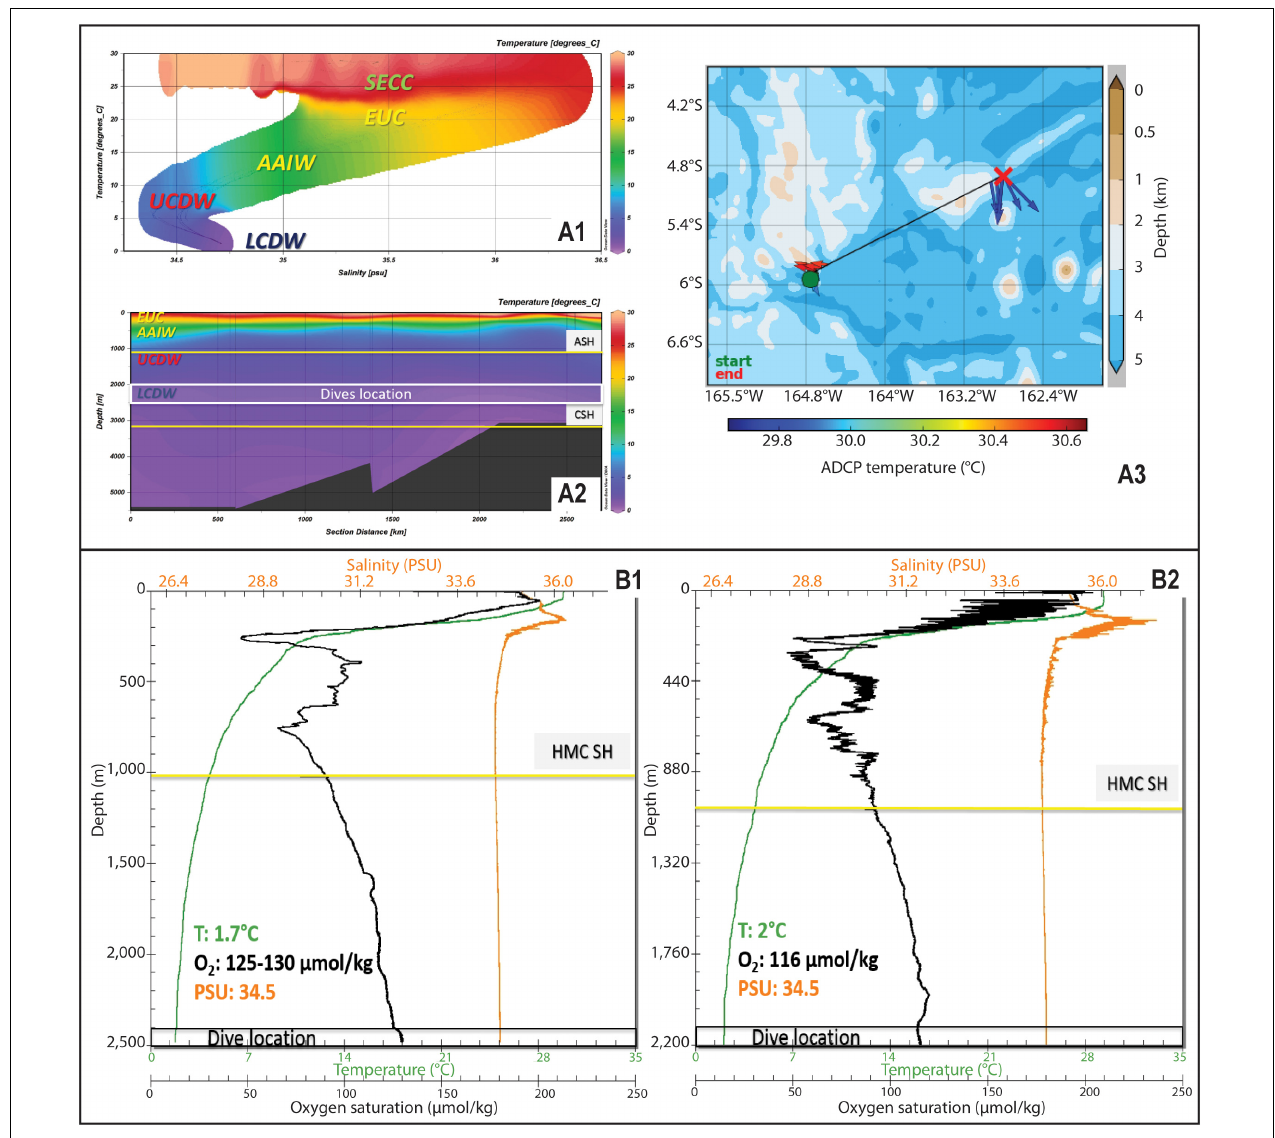
FIGURE 2 | Current data at the dives transect (A1) Temperature-salinity diagram with water masses identified. AAIW, Antarctic Intermediate Water; UCDW, Upper Circumpolar Deep Water; LCDW, Lower Circumpolar Deep Water; SPEW, South Pacific Equatorial Water; EUC, Equatorial Undercurrent, and SECC, South Equatorial Counter Current. (A2) Water masses across the water depths. The dives depths are within the LCDW (white box). Yellow lines indicate the approximate depths of the aragonite saturation horizon (ASH) and calcite saturation horizon (CSH). (A3) Current direction of the top 600 m, collected from ADCP during EX1705. The red arrows give the temperature and shallow water current direction in “Te Tuku.” The blue arrows give the temperature and shallow water current direction in “Te Kawhiti.” (B1) and (B2) are ROV CTD temperature (green lines), oxygen saturation (black lines), and salinity (orange lines) profiles of “Te Tuku” dive (B1) and “Te Kawhiti” dive (B2) . High-Mg calcite saturation horizon (HMCSH) is indicated with yellow lines. Rectangular boxes at the bottom of the graphs show the dive